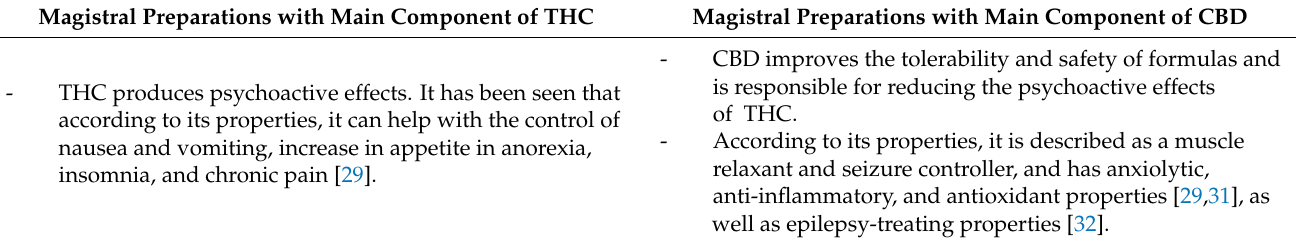
Table 2. Main effects of each magistral preparation based on THC and CBD. Magistral Preparations with Main Component of